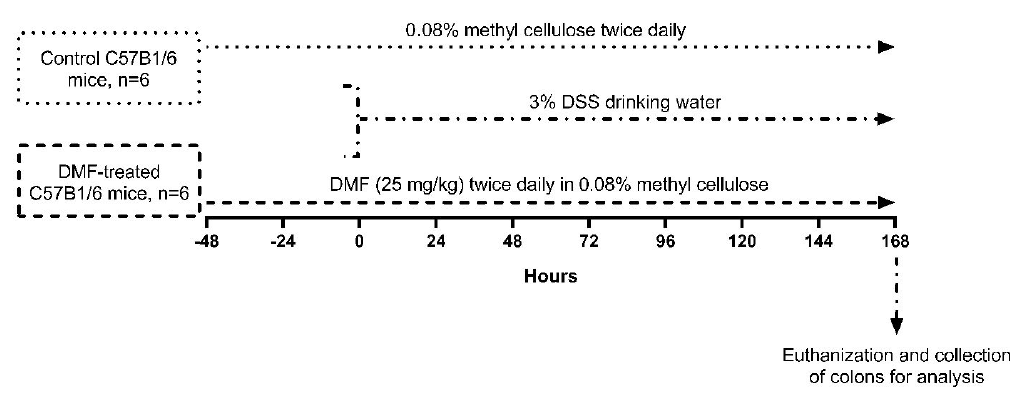
Figure 1. Experimental design outlining the dextran sulfate sodium (DSS)-induced colitis mice model and dimethyl fumarate (DMF) treatment protocol. In the DMF-treated C57B1 / 6 mice group ( n = 6), DMF was dissolved in 0.08% methyl cellulose and given to mice (25 mg / kg) twice daily by oral gavage for 48 h prior to the administration of DSS, and maintained throughout the experiment. Control C57B1 / 6 mice ( n = 6) were given the same amount of methyl cellulose. Both groups were given 3% DSS drinking water for 1 week to induce intestinal inflammation. All mice were then euthanized and their colons were collected for